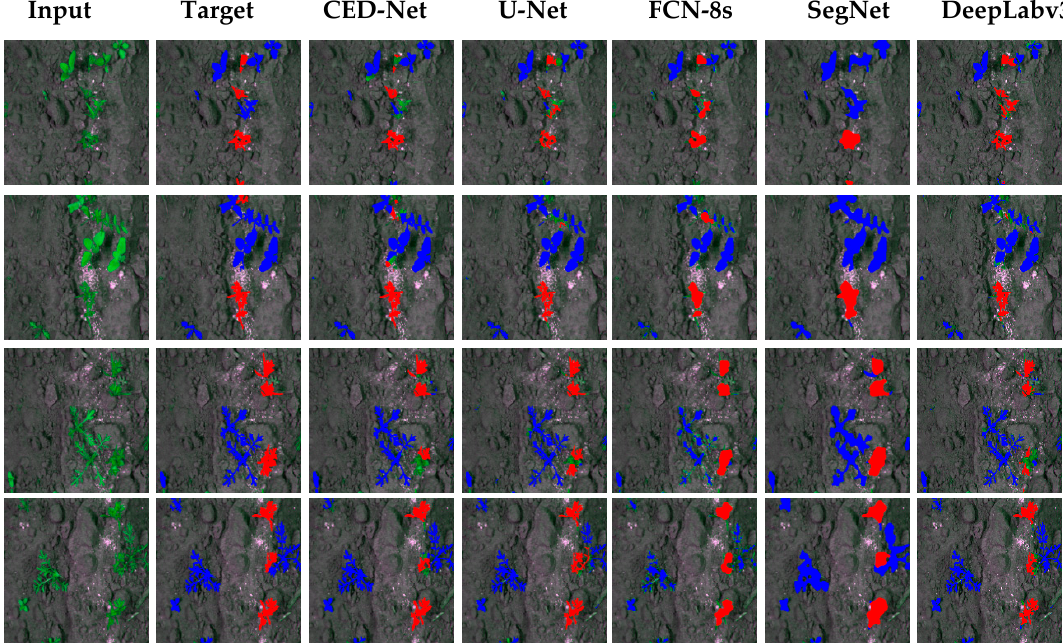
Figure 6. Qualitative analysis for carrot crop and weed dataset.